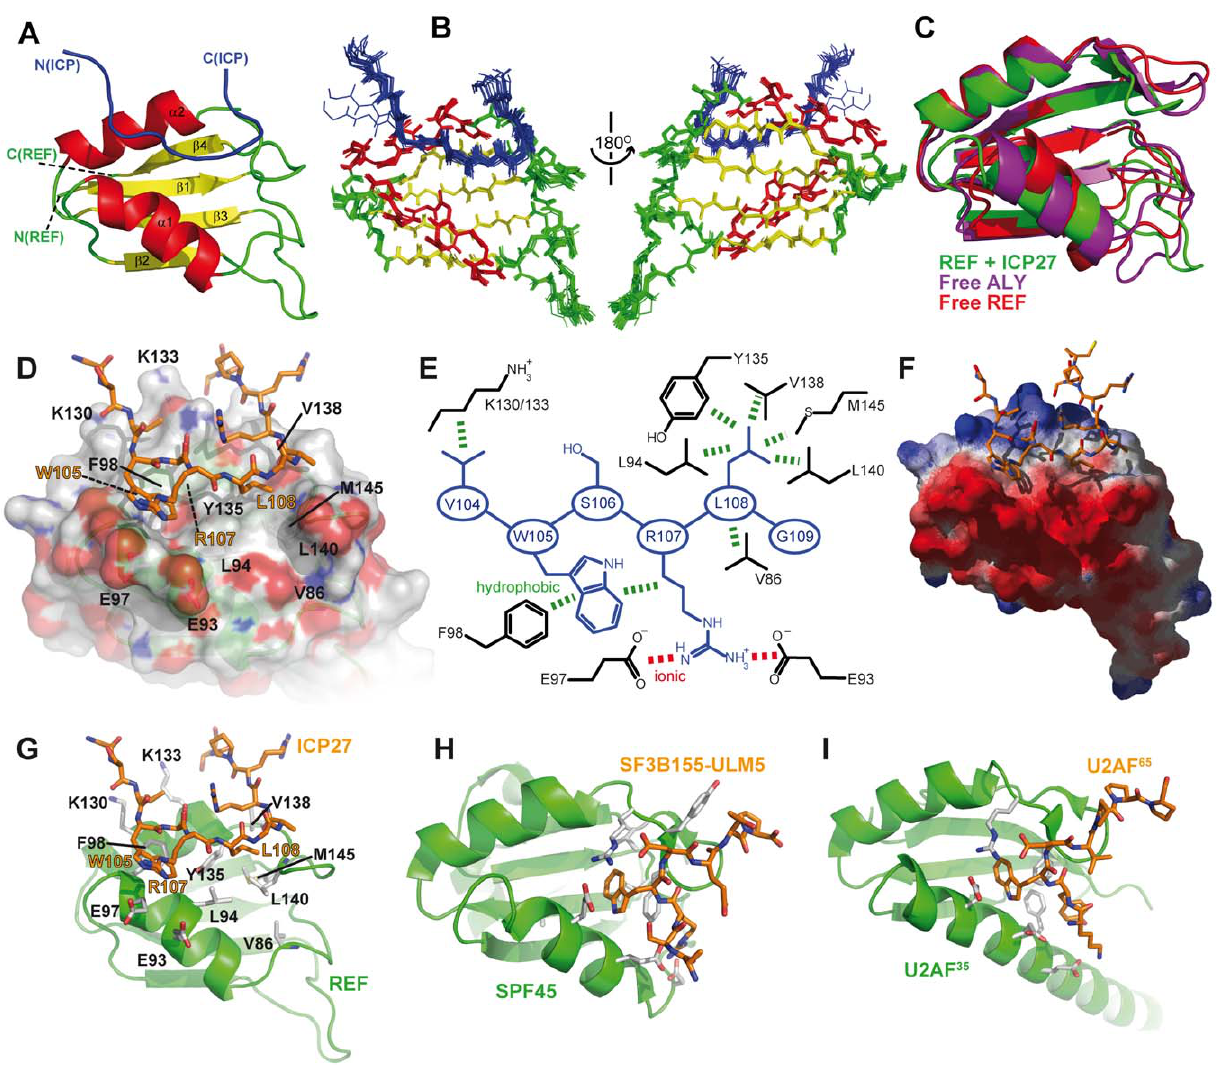
Figure 4. Structure of the REF - ICP27 complex. ( A ) Ribbon representation showing ICP27 coloured blue, and REF RRM coloured green, red and yellow for looped, a -helical and b -sheet regions, respectively. Positions of N- and C-termini of polypeptide chains are labelled. ( B ) Overlay of 20 lowest energy structures with backbone shown in the same orientation, and rotated 180 u . The best-fit superposition is made using heavy backbone atoms of structurally defined regions aa 74–152 of REF and 102–112 of ICP27. Colour-coding is the same as on panel A . ( C ) Overlay of the RRM domains of free REF2-I (red, PDB code 2F3J), free murine Aly (purple, PDB code 1NO8) and ICP27-bound REF2-I determined here (green), demonstrating the shift in a - helix 1 position. ( D ) Representation of REF – ICP27 complex in the same orientation with partially transparent surface. ( E ) Schematic of the REF and ICP27 binding site. ICP27 residues are coloured blue and REF in black; the hydrophobic and electrostatic interactions are indicated by dashes coloured green and red, respectively. ( F ) Electrostatic surface with negative and positive charge coloured red and blue, respectively. Bottom row shows for comparison the known structures of RRM domains (green) with bound peptide ligands (orange). ( G ) REF 54–155 in complex with ICP27 103–138 , determined here. ( H ) UHM domain of human SPF45 in complex with SF3B155-ULM5 (PDBcode 2peh, [44]). ( I ) U2AF 35 in complex with U2AF 65 (PDB code 1jmt, [42]).